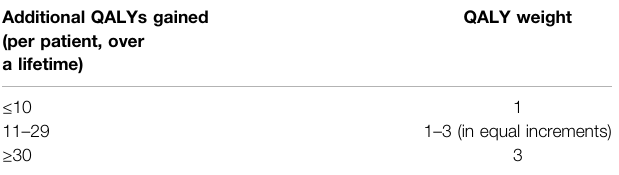
TABLE 3 | QALY weights applied by NICEs HST process (adapted from: NICE Interim Process and Methods of the Highly Specialised Technologies Programme Updated to re fl ect 2017